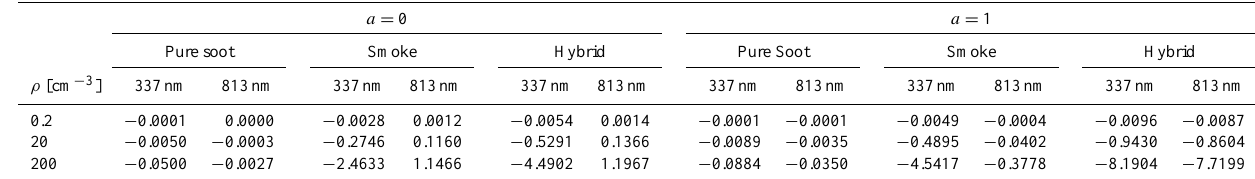
Table 6. Percent difference (at 35km altitude) between simulations including only air vs. air plus carbonaceous aerosols in a 5km layer extending from 10–15km. Pure soot and smoke particles are described in Table 2, while hybrid particles have the absorption of pure soot and the size of smoke, representing a limiting case of the effect of carbonaceous aerosols in limb-scatter observations. a = 0 a = 1 Pure soot Smoke Hybrid Pure Soot Smoke Hybrid ρ [cm − 3 ] 337nm 813nm 337nm 813nm 337nm 813nm 337nm 813nm 337nm 813nm 337nm 0.2 − 0.0001 0.0000 − 0.0028 0.0012 − 0.0054 0.0014 − 0.0001 − 0.0001 − 0.0050 −